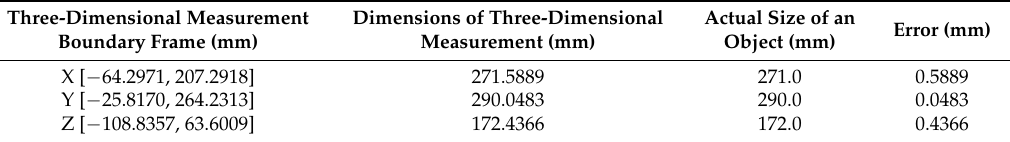
Table 4. Comparison of measurement dimensions of head 3D reconstructions and actual size of the Terra-Cotta Warriors.